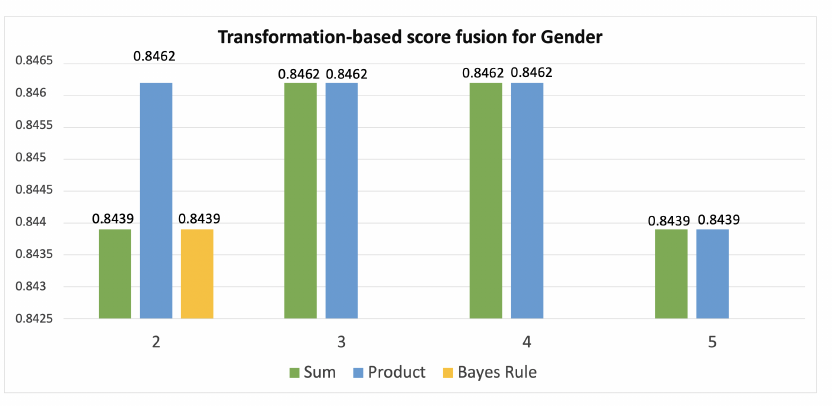
Figure 6. The results of combining 2, 3, 4, and 5 classifiers in gender recognition using sum, product and Bayes rule as fusion